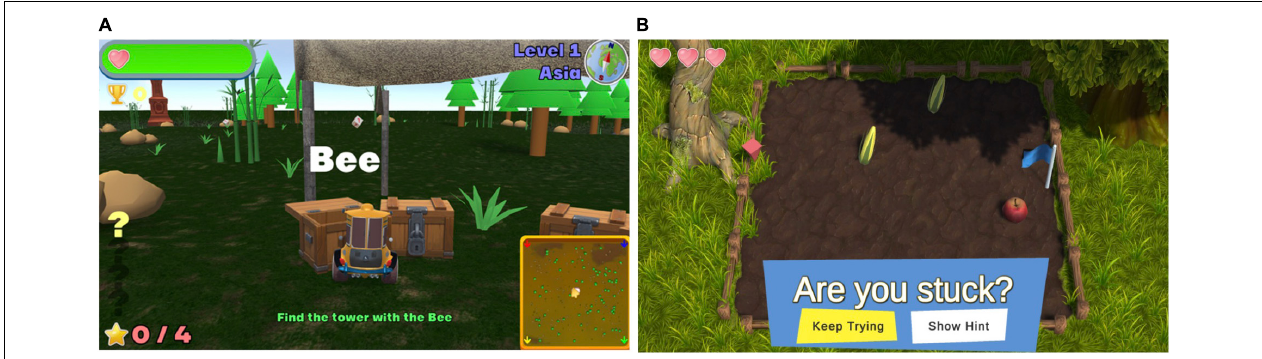
FIGURE 5 | (A) One of the changes made to Sunday Driver included the addition of prompts to instruct individuals based on their gameplay. For example, players would be reminded of the goal if they remained stationary for too long. (B) One of the changes made to Farm Quest included the addition of a time-activated hint trigger, offering the player the option of a hint for the next